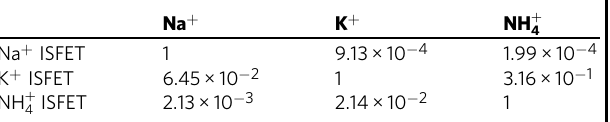
Table 2 Nikolskii selectivity coef fi cients K ij for the three cation ISFETs with respect to three